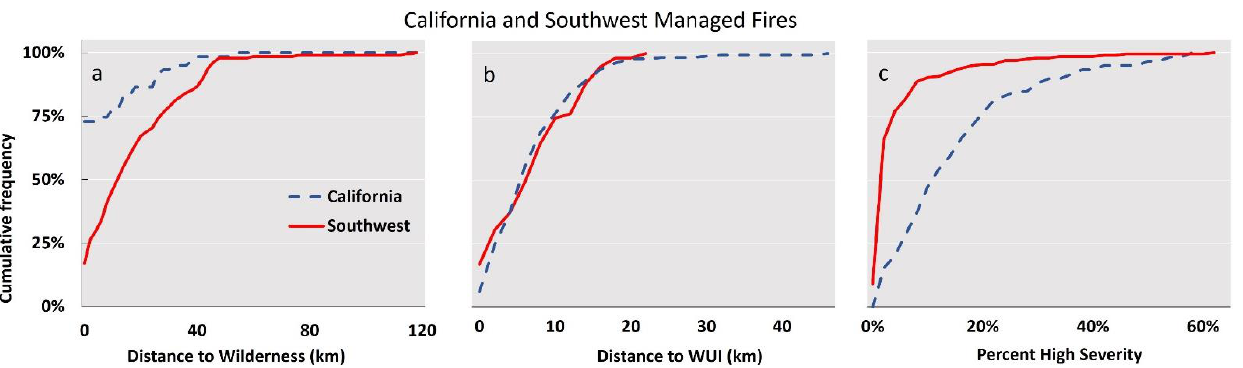
Figure 3. Comparison of managed wildfires in California ( n = 59) and the Southwest ( n = 195) based on ( a ) distance to wilderness, ( b ) distance to WUI, and ( c ) the percentage of high-severity burn area. Managed wildfires in California were closer to the wilderness and had a smaller percentage of high-severity fire but were not different in terms of distance to WUI compared to managed wildfires in the